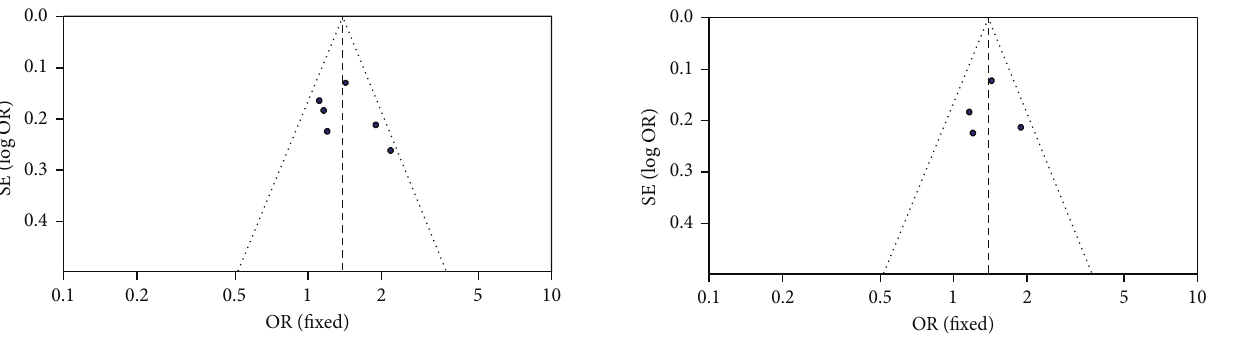
Figure 2: Funnel plot for studies of AF associated with Mink S38G gene polymorphism under an allelic genetic model (distribution of G allelic frequency of Mink S38G gene polymorphism) in the Chinese population. The horizontal and vertical axis correspond to the OR and confidence limits. OR: odds ratio; SE: standard error.